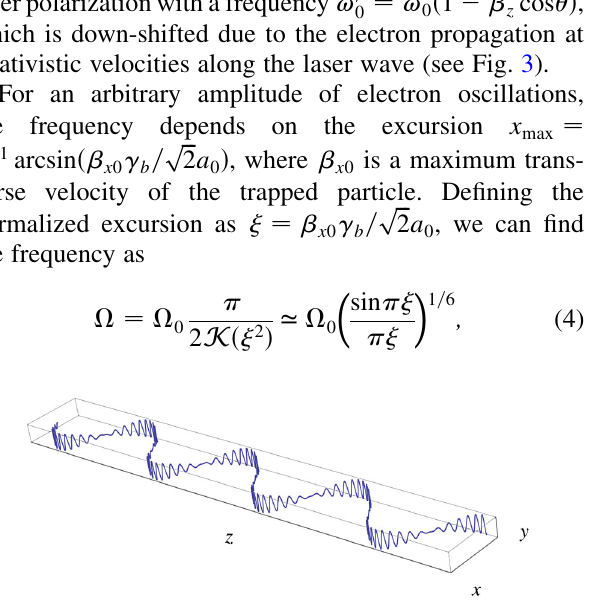
FIG. 3. Typical electron trajectory in an optical lattice.